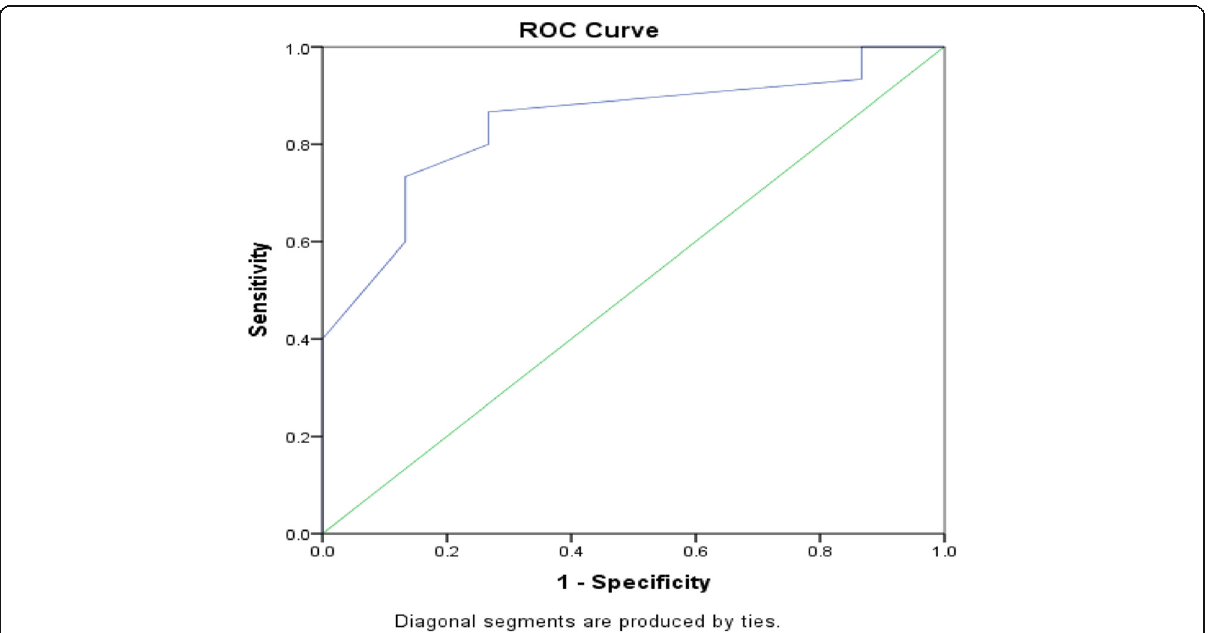
Fig. 4 Receiver operating characteristic curve (ROC) shows that the sensitivity and specificity of the calreticulin (CRT) level in discriminating renal transplant recipients with stable allograft function from renal transplant recipients with chronic allograft dysfunction were 86.7% and 73.3%, respectively, at a cut-off level of 2.6 ng/ml (area under the curve = 0.